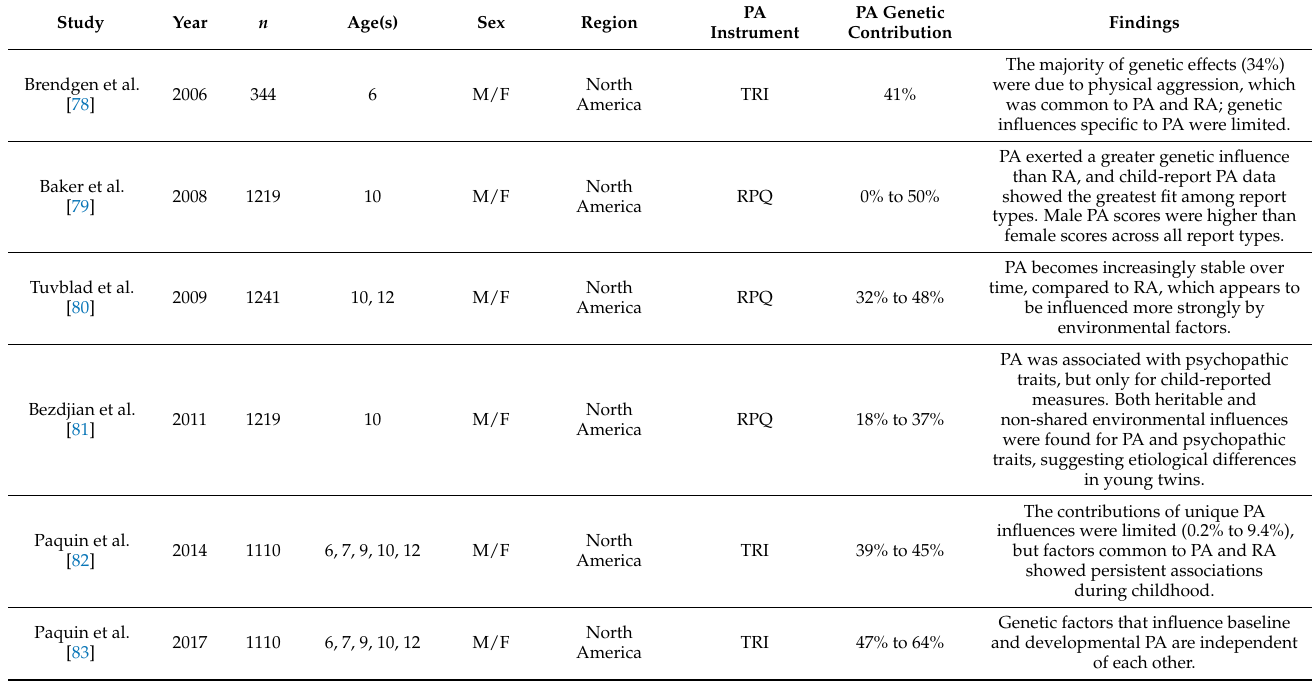
Table 3. Twin studies that evaluate proactive aggression arranged according to year of publication.